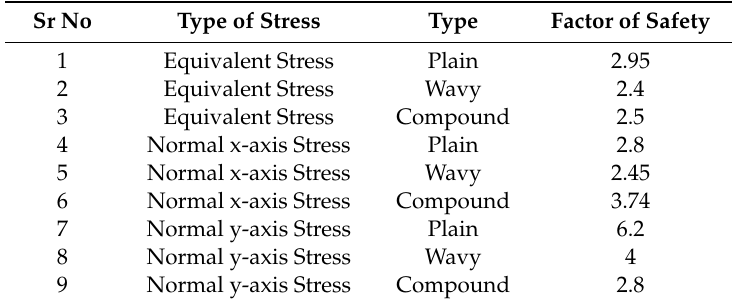
Table 3. Factor of safety (FOS) along path 1 for plain, wavy and compound